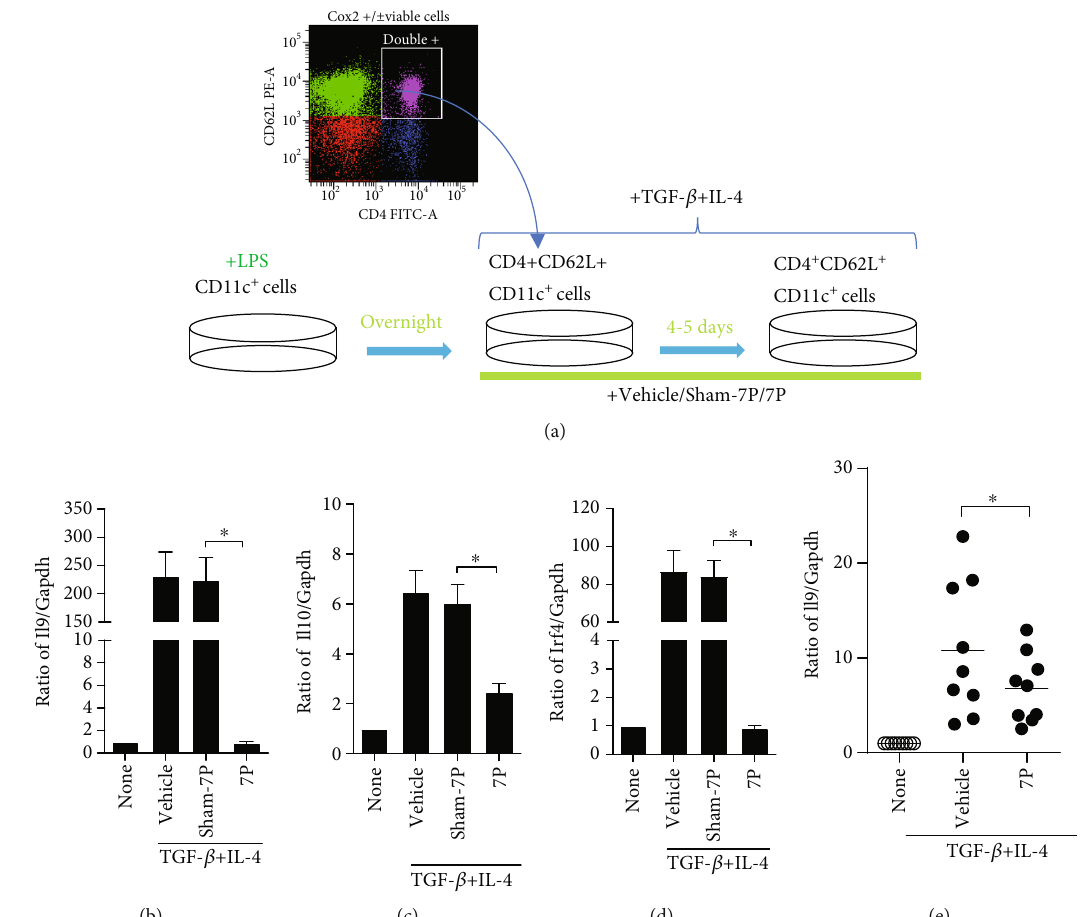
Figure 2: Th9 di ff erentiation from naïve CD4 + T cells is inhibited by 7P in vitro . (a) Dendritic cells (DC, CD11c + cells) were isolated from the spleen and matured with LPS overnight. Naïve CD4 + T cells were then isolated from spleens of C57BL6J mice, and LPS-treated DCs were treated with anti-CD3 (3 μ g/mL), anti-CD28 (3 μ g/mL), anti-INF- γ (3 μ g/mL), transforming growth factor- (TGF-) β (10 ng/mL), and IL-4 (10 ng/mL) for 4 – 5 days with 7P, sham-7P, or vehicle. The cells were then restimulated for 4h with 12-O-tetradecanoylphorbol-13-acetate and ionomycin (500ng/mL each) in the presence of brefeldin A (1 mg/mL) before real-time PCR analysis. (b – d) Cells treated with TGF- β and IL-4 were collected, and prepared RNA was reversed to cDNA. Il9 , Il10 , and Irf4 mRNA were ampli fi ed by quantitative polymerase chain reaction (qPCR) after treatment by anti-CD3, anti-CD28, anti-INF- γ , TGF- β , and IL-4 with 7P, sham-7P, or vehicle. Data were representative of 7 – 14 independent experiments ( n = 7 – 14 , ∗ p < 0 : 05 ). (e) Human naïve CD4 + T cells were isolated from peripheral blood and di ff erentiated into Th9 cells with anti-CD3, anti-CD28, TGF- β , and IL-4 plus 7P and vehicle. Il9 mRNA was also assayed by qPCR ( n = 5 ; p ∗ < 0 : 05